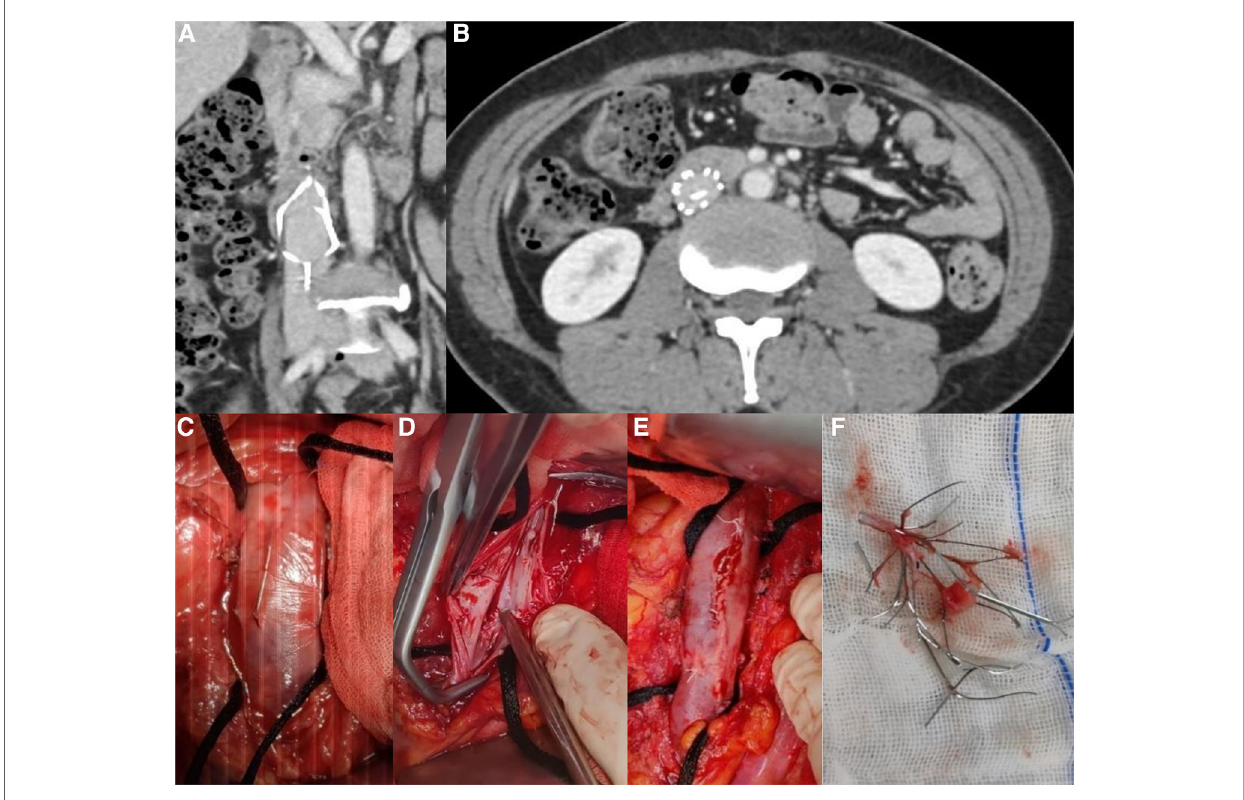
FIGURE 2 ( A ) Retention of non-conical fi lter for 8 years ( B ) Filter fracture ( C ) Filter penetrating the IVC ( D ) Post-repair image of IVC endothelium after fi lter removal ( E ) Suture of the IVC ( F ) Removed fi lter after